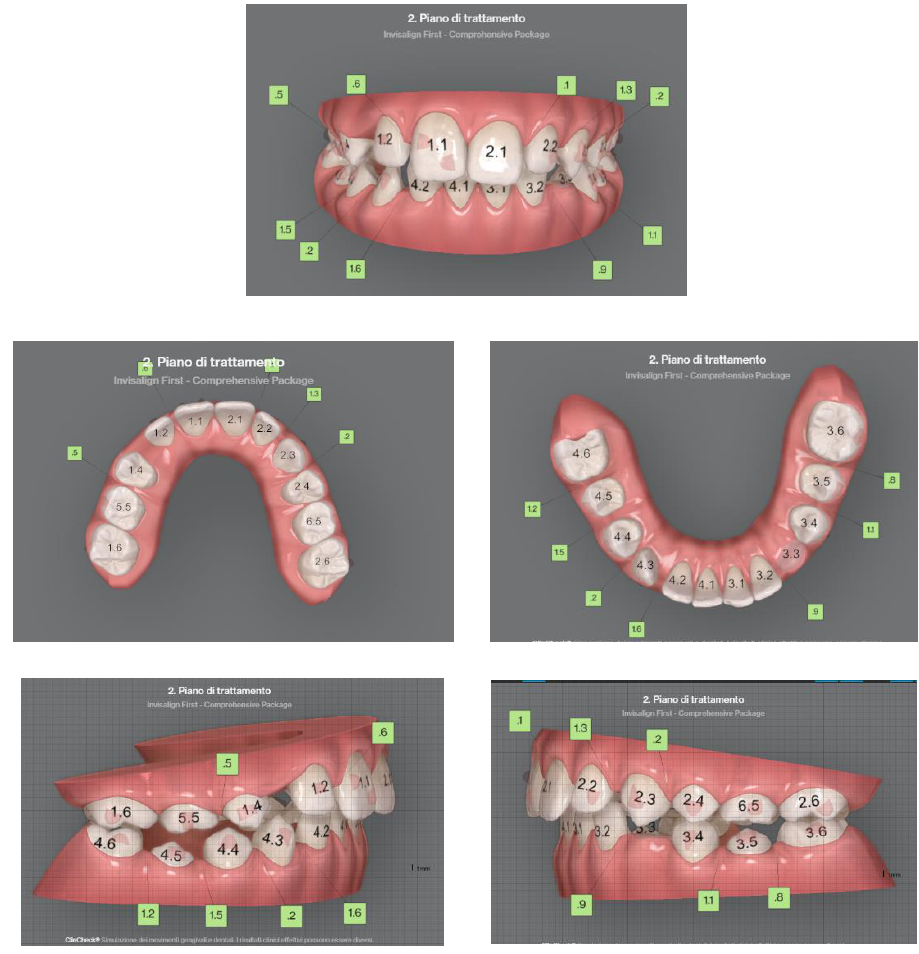
Figure 6. Clinical case treated with Invisalign© aligners. Intraoral views from ClinCheck. Frontal, upper, and lower occlusal and lateral view of occlusion before the beginning of treatment.